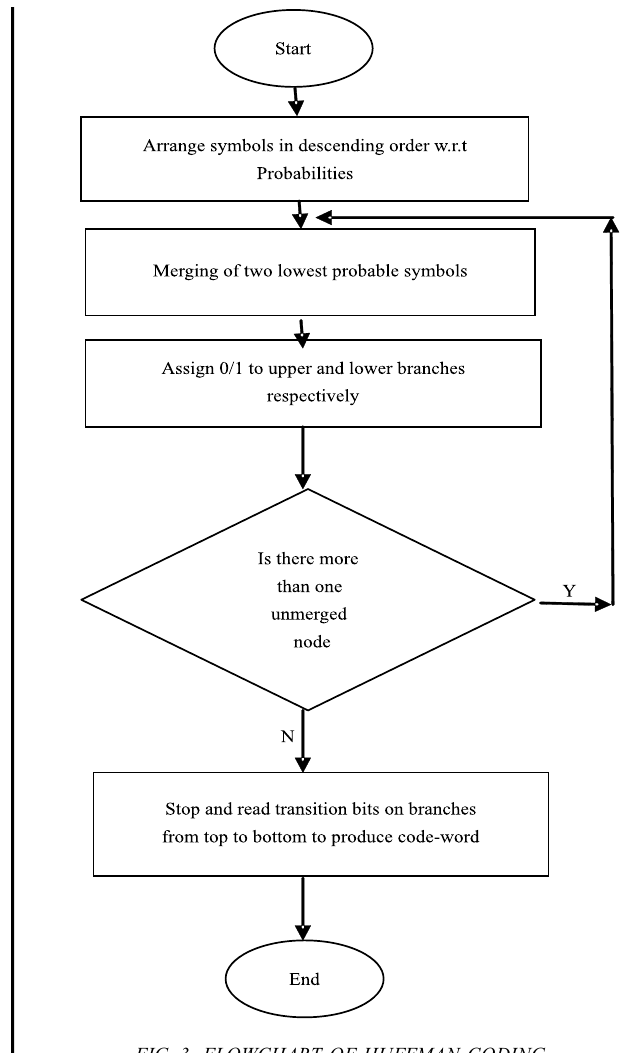
FIG. 3. FLOWCHART OF HUFFMAN TABLE 4. SYMBOLS WITH PROBABILITIES AND CODE-WORDS